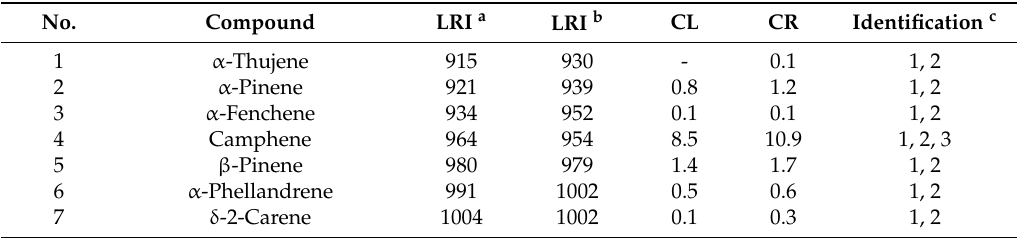
Table 1. Chemical composition of the essential oils (EOs) isolated from the peels of C. medica cv.